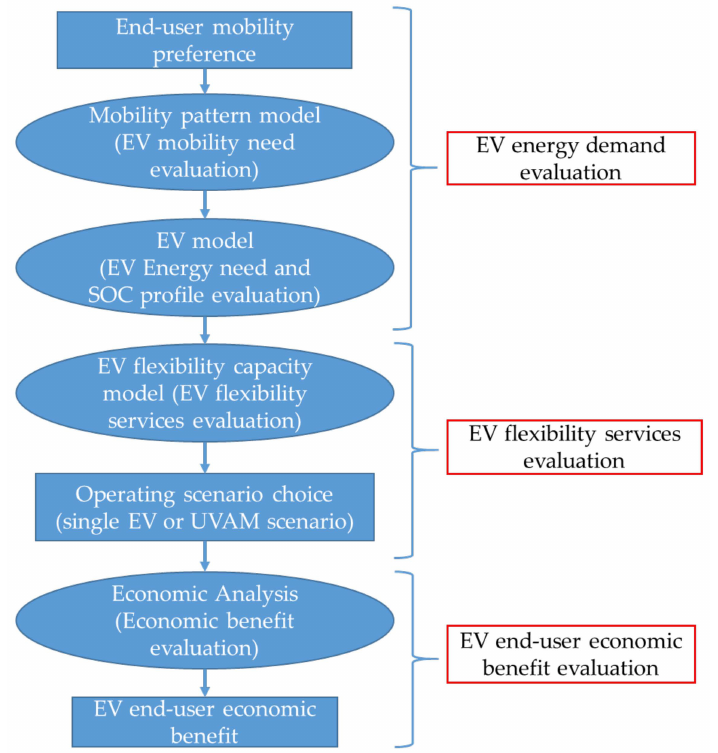
Figure 2. EVFlex flow